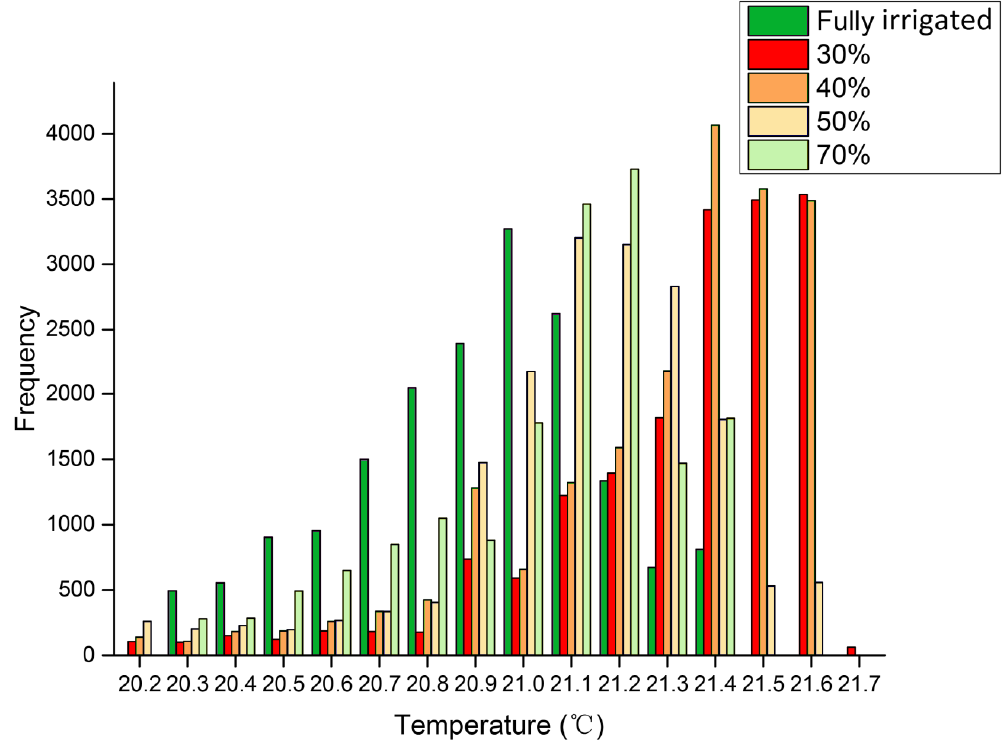
Figure 2. Canopy temperature distributions of the water-stressed and block groups.